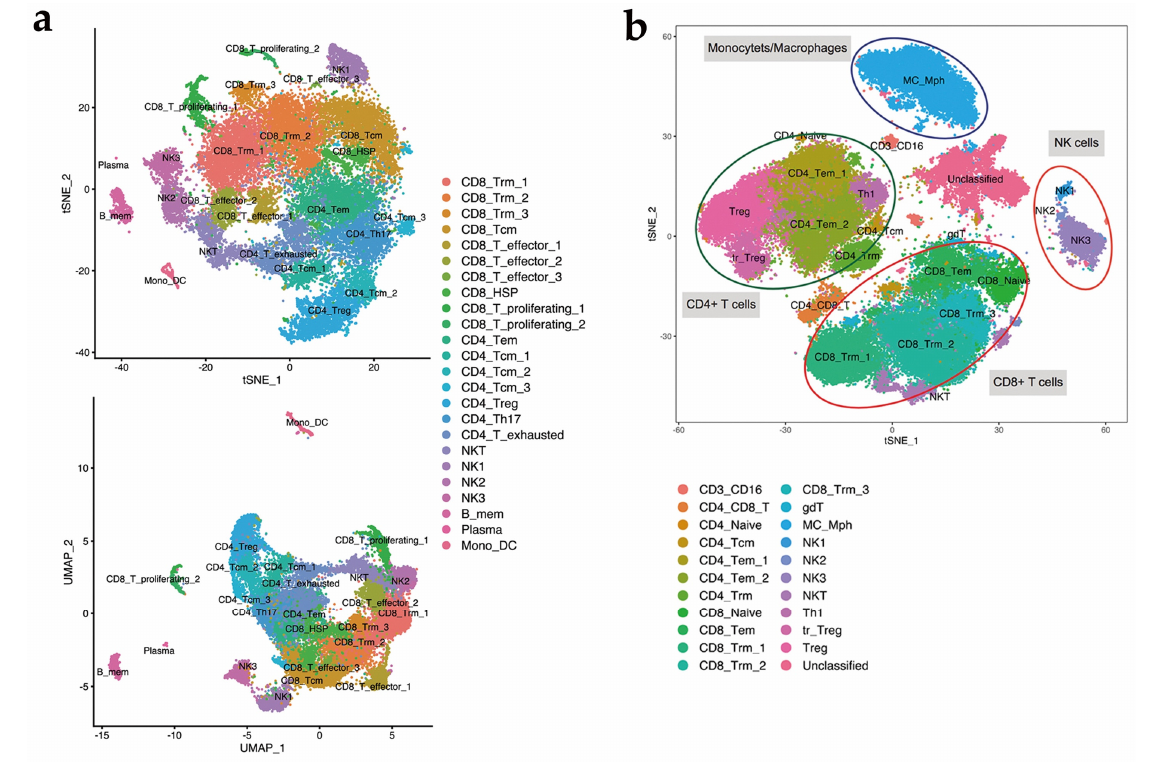
Figure 2. Single-cell transcriptomic and mass cytometry analysis of EC TILs. ( a ) tSNE analysis and UMAP methods were applied for the nonlinear dimension reduction analysis. Clusters were determined with the built-in graph-based method. Each cluster was annotated with a cell type according to marker gene expression; ( b ) Eight thousand TILs from 5 patients with type I EC were analyzed using mass cytometry. Unsupervised clustering analysis was applied using “PhenoGraph”, and dimension reduction was completed using tSNE. Clusters were annotated according to the expression pattern of marker proteins. Three NK cell subsets and 3 TRM subsets were identified, consistent with the findings from scRNA-seq.